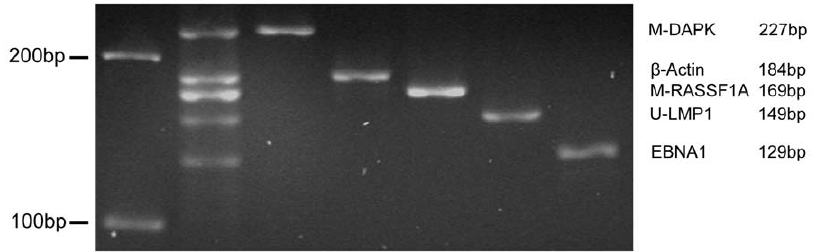
Figure 1. Comparison of MMSP and corresponding single MSP assays. Same amount of bisulfite converted genomic DNA of Namalwa cells were used as template for both multiplex and single MSPs. All the markers demonstrated highly specific bands in this MMSP assay. There was an excellent concordance with the relative density of the five bands including b -ACTIN as internal control between MMSP and single MSPs. doi:10.1371/journal.pone.0045908.g001 PLOS ONE |